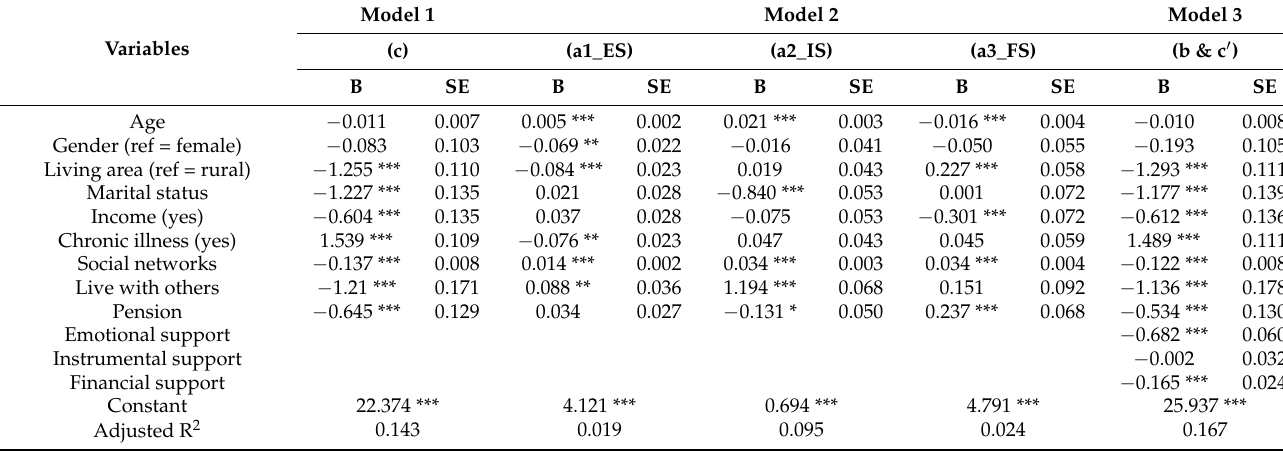
Table 3. Mediating effects of IS in the association between pension insurance and depressive symptoms ( N = 6687 ).